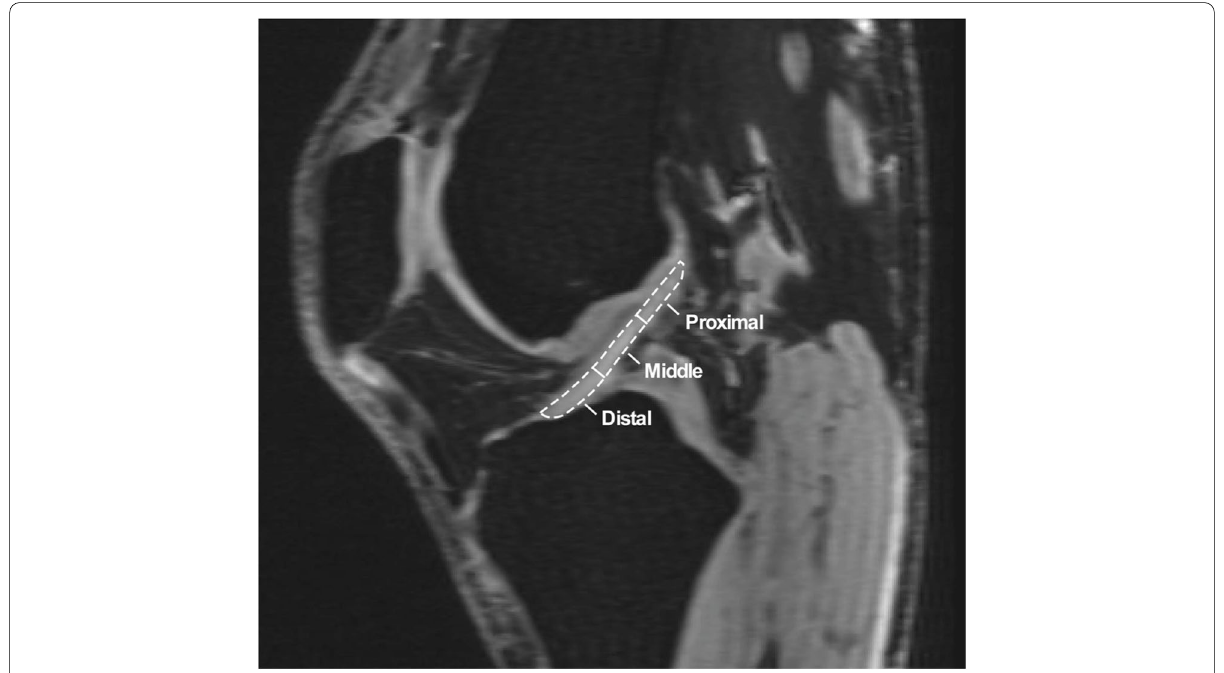
Fig. 1 On the sagittal-oblique sections of the ACL, the substance of the ligament was divided into three regions of interest: proximal, middle and